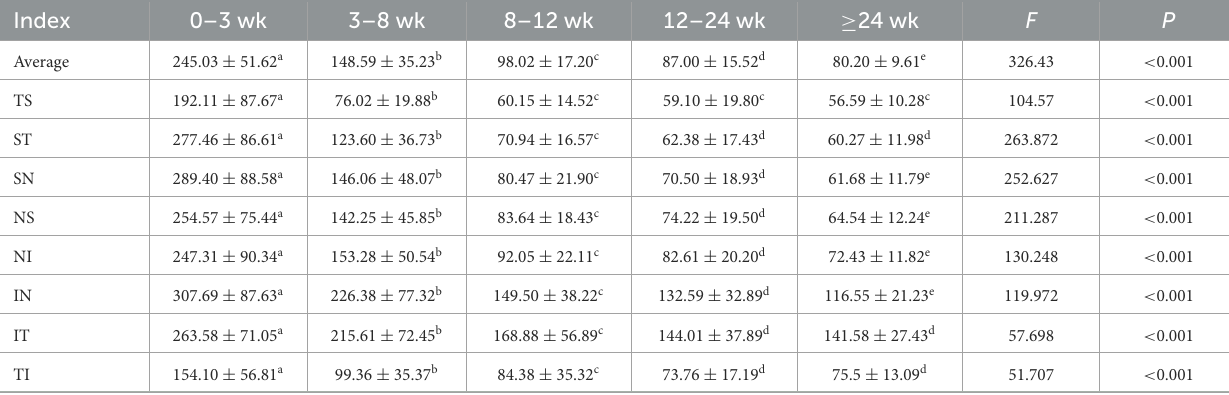
TABLE 2 Changes of pRNFL in patients with NAION at different stages.